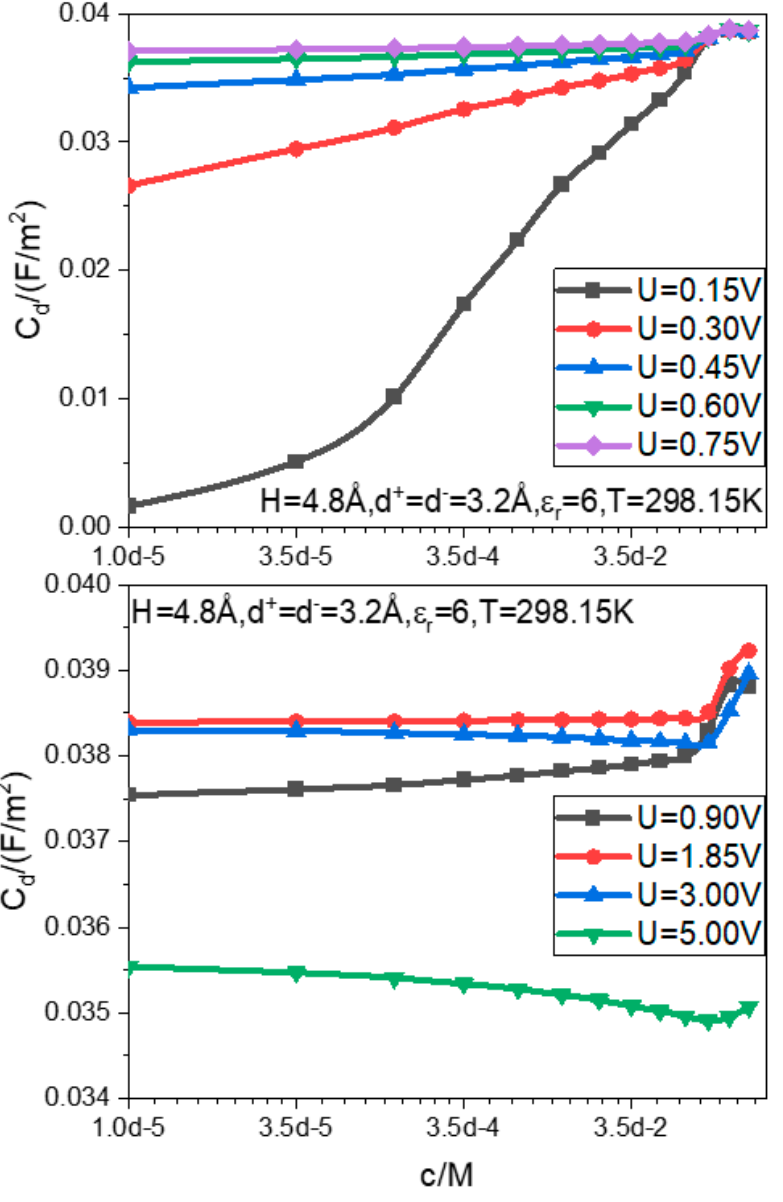
Figure 2. Function relation between the differential capacitance C d and bulk electrolyte concentration c at different electrode potentials U .